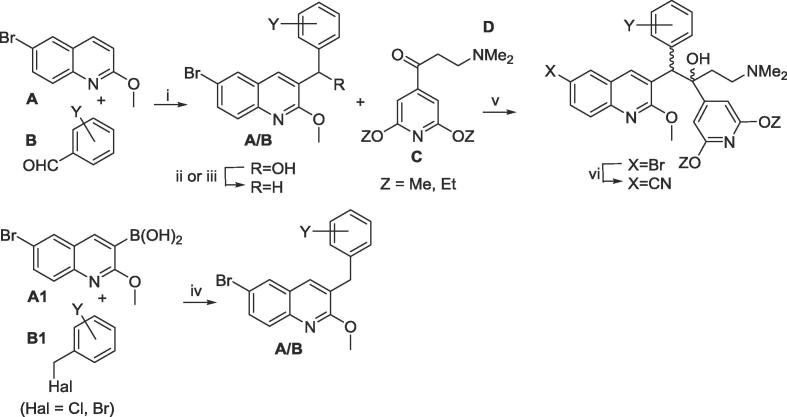
Synthesis of substituted analogues of 1. Reagents and conditions: (i) LiTMP, THF, −75 °C, 1.5 h then the appropriate aldehyde B, −75 °C, 4 h; (ii) Et3SiH, TFA, DCM; (iii) MsCl, Et3N, DMF, then NaBH4; (iv) Cs2CO3, Pd(PPh3)4, PhMe/DMF, 110 °C (sealed tube), 5 h; (v) LDA, THF, −75 °C, 1.5 h then the appropriate ketone C/D, then HOAc; (vi) Zn/Zn(CN)2, Pd2(dba)3/P(o-tol)3, DMF, 50 °C, then separation of the diastereomers by SFC HPLC.